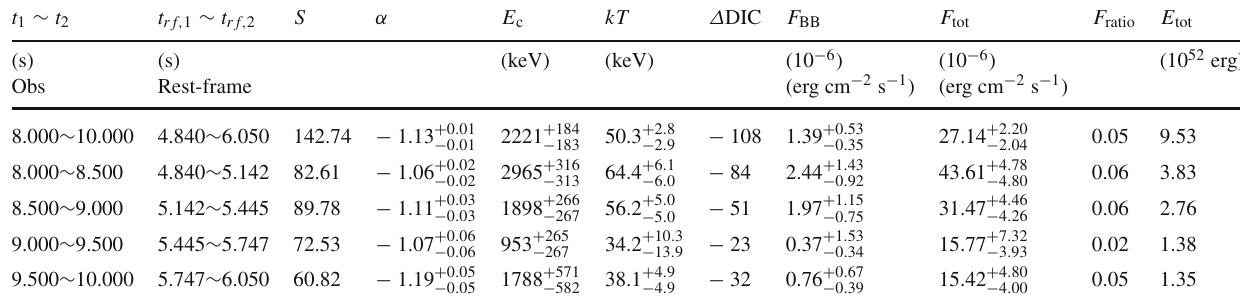
Table 1 The time-resolved spectral fit parameters for GRB 180720B (CPL + BB model) during the UPE I phase ( t rf = 4 . 84 s to t rf = 6 . 05 s).